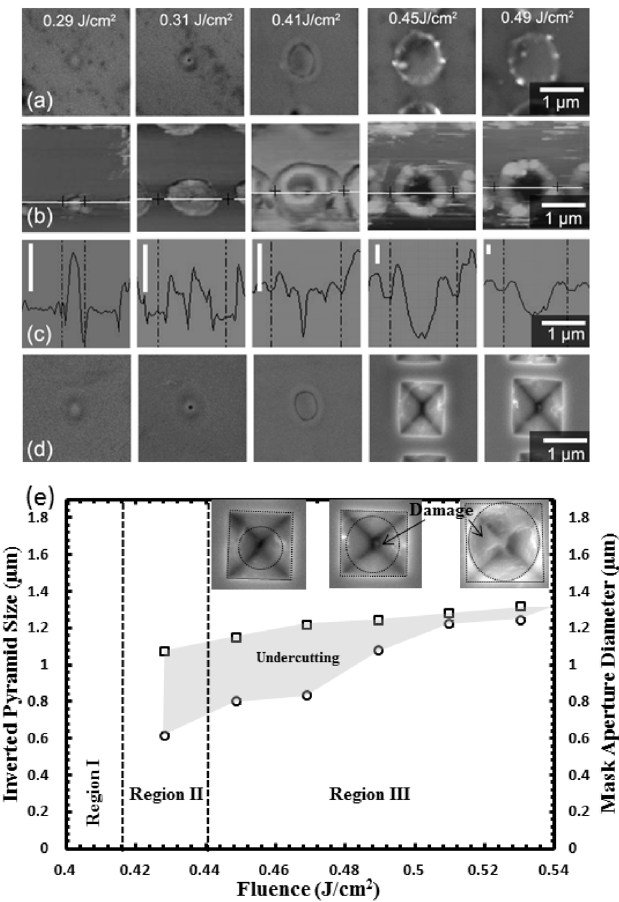
Fig. 2. (a) SEM images of surface modifications in a 20 nm SiN x film on c-Si as a function of laser fluence. Correspond- ing atomic force micrographs and line profiles of the features are shown in (b) and (c), respectively. The vertical scale bar is 20 nm in each panel of (c). (d) Shows post-etching SEM micro- graphs of the morphology shown in (a), when etched in KOH for 2.5 min. The ablation crater diameter (circular marker (o)) and the inverted-pyramid size (square marker ( (cid:3) )) observed after 2.5 min KOH etching are shown in (e) together with se- lect SEM images as a function of fluence. The mask aperture and the inverted pyramid are outlined by a dashed circle and a square, respectively, in each of the SEM images. Fluence zones for blistering (Region I) and low (Region II) and high (Region III) reproducible ejection are identified.